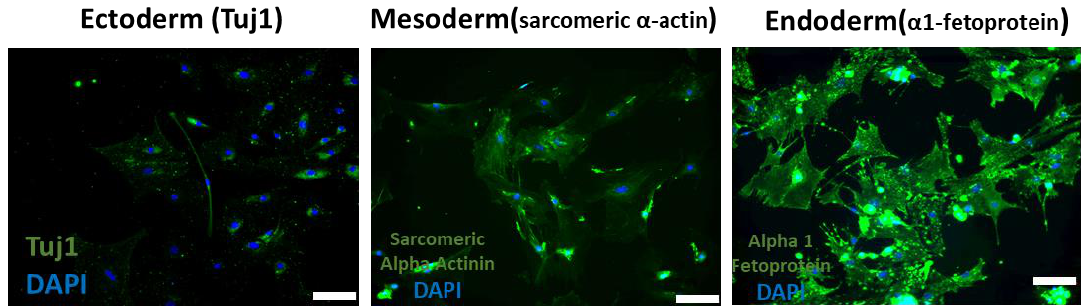
Figure 4. In vitro differentiation potential of SSVC-treated cells into three germ layers (scale bars = 100 µm).